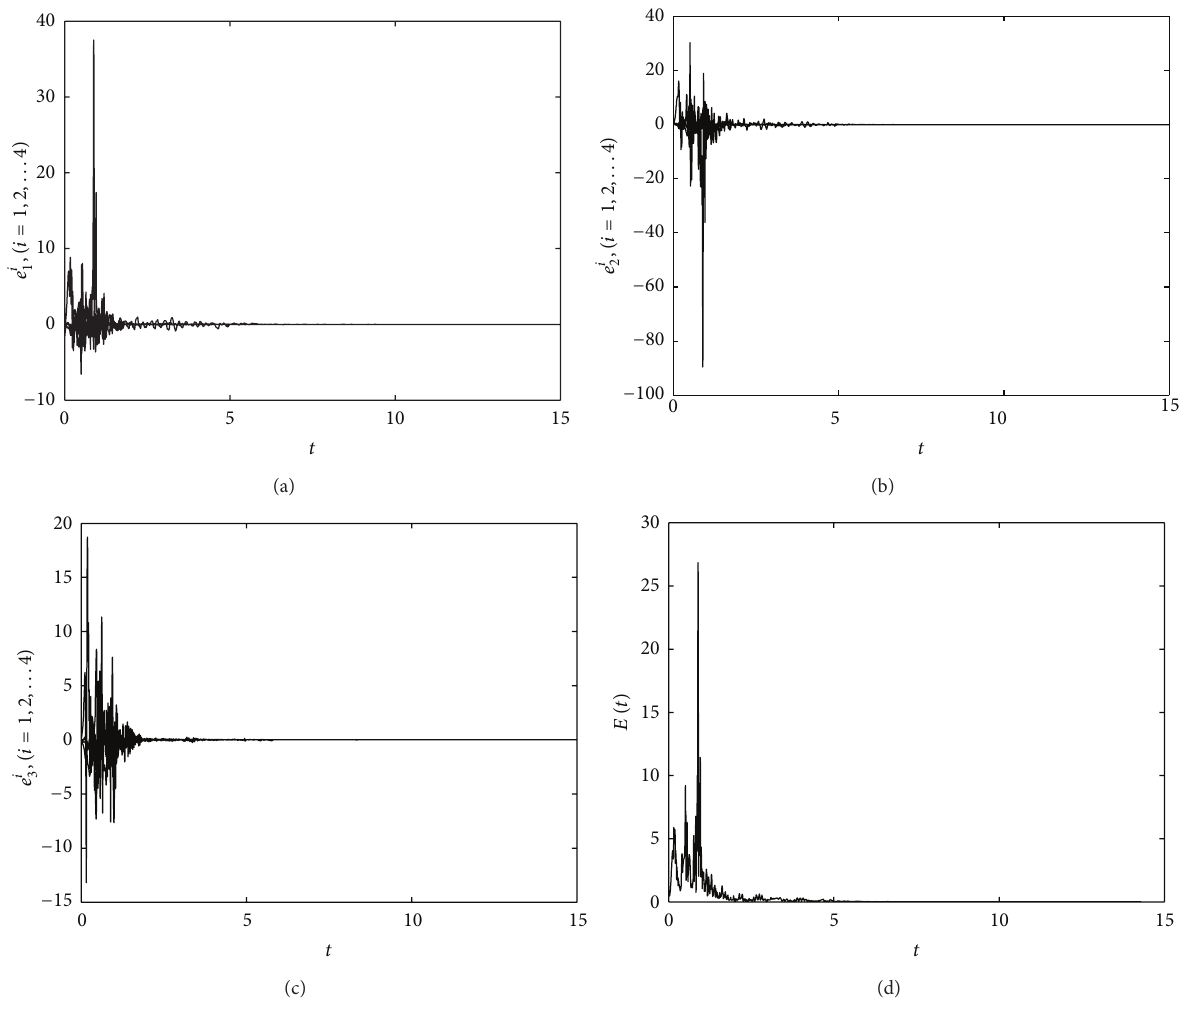
Figure 1: Synchronization errors 𝑒 𝑖 (𝑡) and 𝐸(𝑡) of